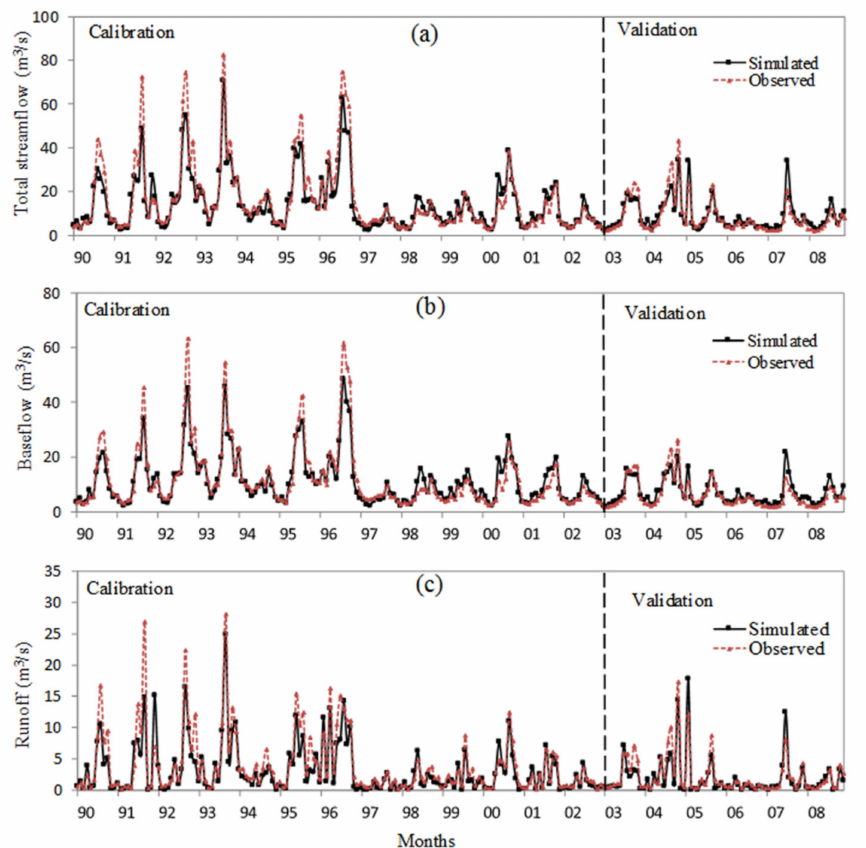
Figure 5. Comparison of observed and simulated monthly ( a ) total streamflow, ( b ) baseflow, and ( c ) runoff during calibration and validation in the